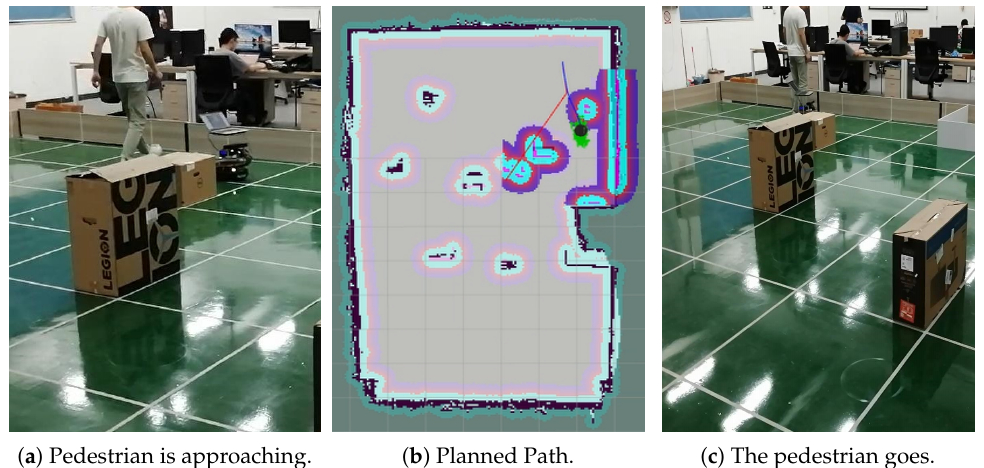
Figure 17. Snapshots of path planning in dynamic situation with an aggressive